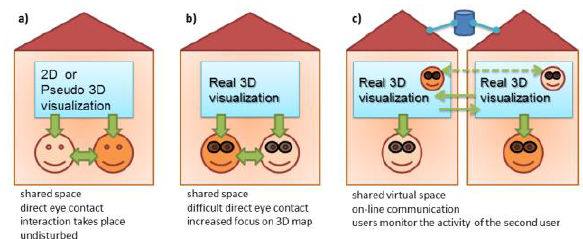
Fig. 4. Different possibilities of utilization of available technologies for collaboration in 3D virtual space User's behavioral activity during controlling an interface can be effectively measured and at the same time, the user’s motor activity and freedom of movement is not limited by the